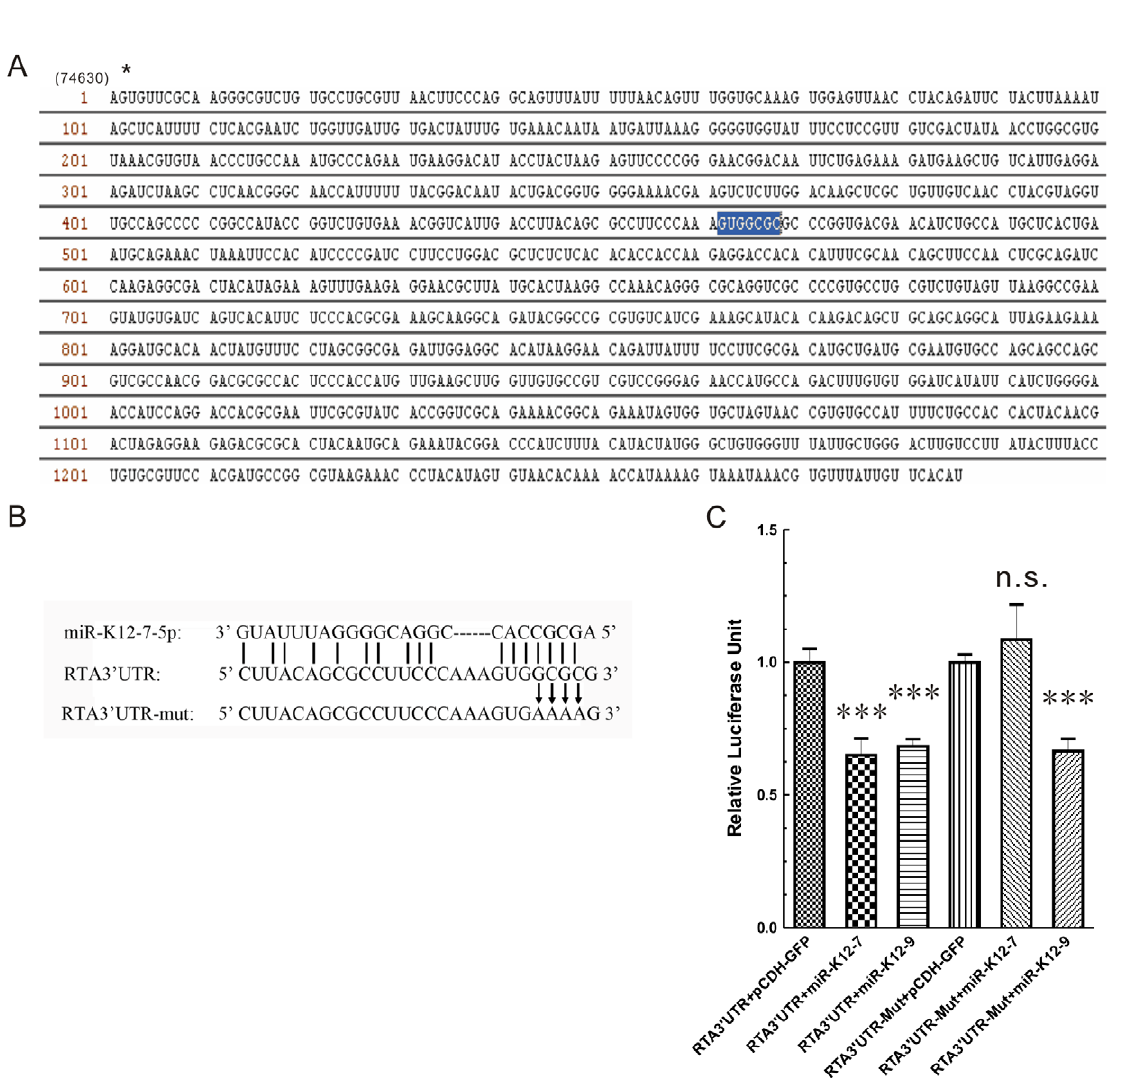
Figure 2. The seed-match site is essential for the regulation of RTA by miR-K12-7-5p. (A) The type I RTA 3 9 UTR (nt 1–1286) contains one perfect seed-match site (highlighted). *74630 indicate the starting site position in the KSHV genome (accession number: U75698). (B) Potential base pairing between miR-K12-7-5p and its predicted pairing site in RTA3 9 UTR. Watson–Crick base pairs are indicated with vertical lines. The mutations made in the 3 9 UTR are shown below the wild-type sequences. (C) Site-directed mutagenesis demonstrates that the seed match site is essential for the regulation of RTA expression by miR-K12-7-5p. HEK293 cells were cotransfected with 50 ng pGL3–RTA3 9 UTR or pGL3–RTA3 9 UTR-mut and 1 m g miR- K12-7 or miR-K12-9 expression construct, or the corresponding empty vector. pRL–SV40 (4 ng) was transfected as the internal control. Luciferase activity was measured 24 h after transfection. The data shown are from six independent transfections. *** P , 0.001; n.s., not significant, t- test.